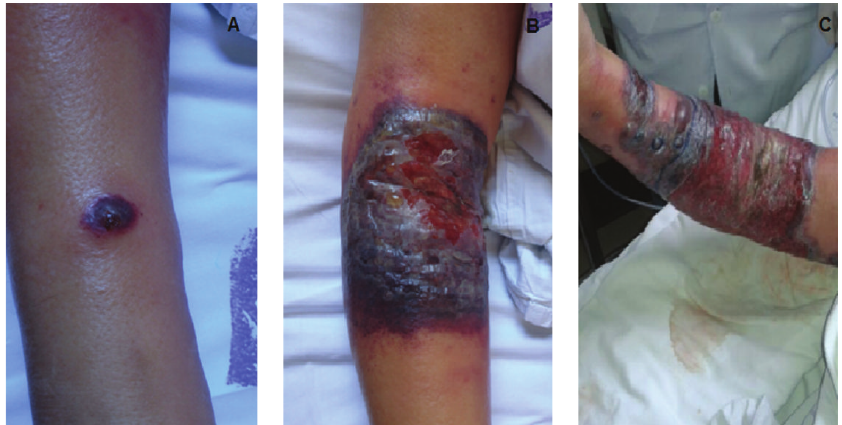
Figure 1: Evolution of lesions in the right antecubital region. (A) A pustular, erythematous, and painful lesion that progressed quickly to ulceration and was circumscribed by an erythematous halo at the site of right antecubital venous puncture. (B) Increased injury refractory to antibiotics. (C) After nine days, the lesion evolved into an erythematous-infiltrated plaque with a hemorrhagic center followed by ulceration circumscribed by erythematous-violet shades of bullous satellite lesions.